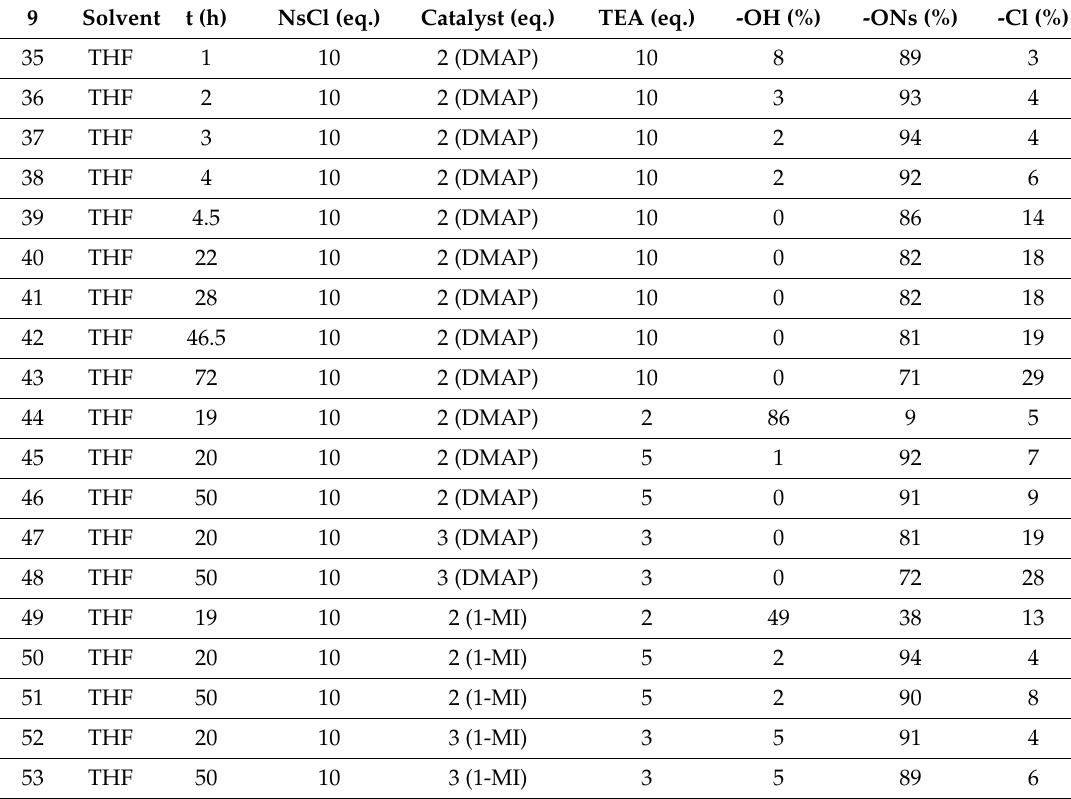
Table 4. The e ff ect of the reaction conditions on the nosylation of PIB all -OH at room